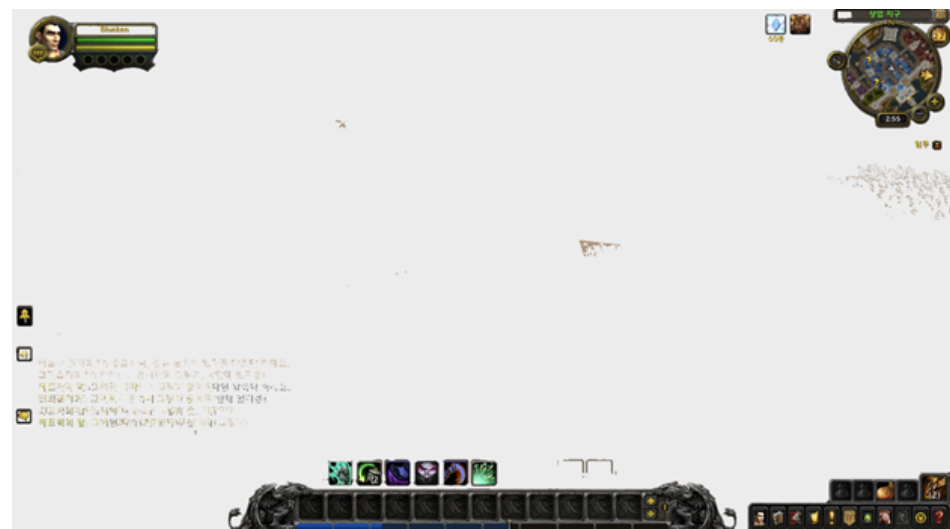
Figure 4. Automatically generated experimental data.